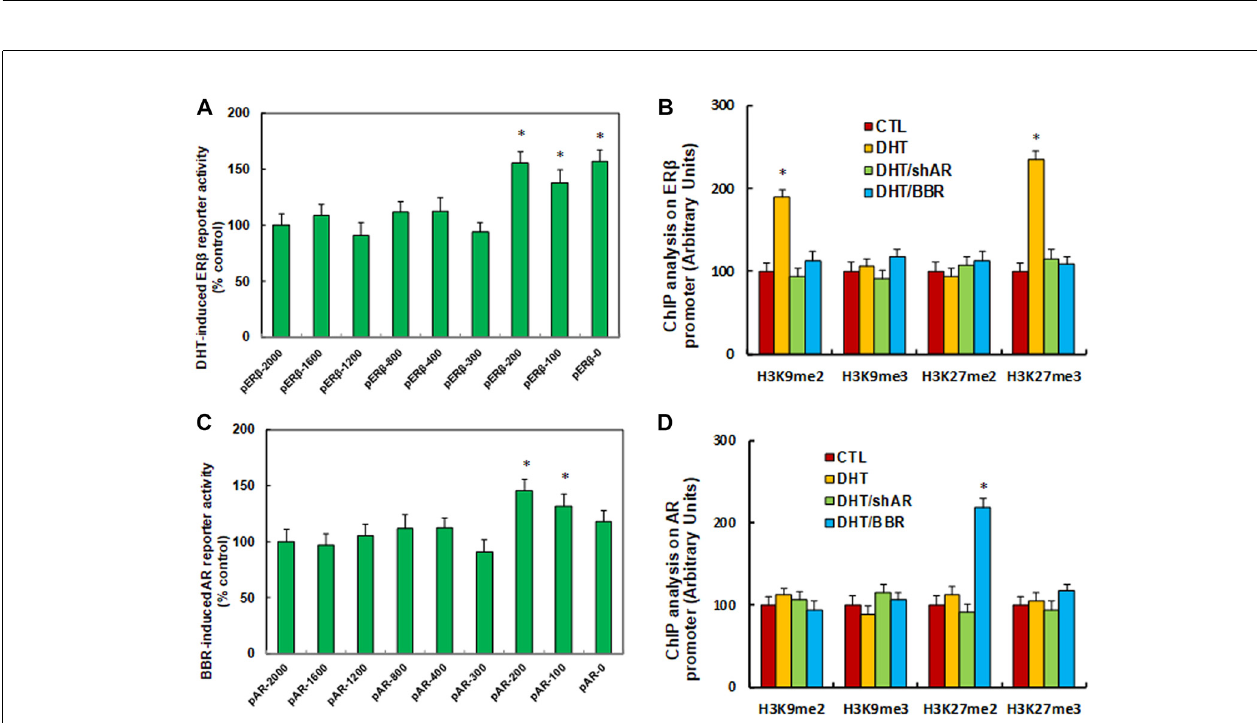
FIGURE 2 | DHT-mediated ER β suppression and BBR-mediated AR suppression by histone methylation on the promoters. (A) The conditional immortalized ACS-5003 neurons were transiently transfected by either ER β full length (pER β -2000) or deletion reporter plasmids. After 24 h, the cells were treated by either control (CTL) or 10 nM DHT for 24 h, and DHT-induced relative reporter activities (% control) were calculated, n = 4. ∗ P < 0.05, vs. pER β -2000 group. (B) The human ACS-5003 neurons were treated by CTL, 10 nM DHT (DHT), DHT with AR knockdown by lentivirus (DHT/shAR), or DHT with BBR (DHT/BBR) for 24 h, and cells were harvested for ChIP analysis, n = 4. ∗ P < 0.05, vs. CTL group. (C) The conditional immortalized ACS-5003 neurons were transiently transfected by either AR full length (pAR-2000) or deletion reporter plasmids. After 24 h, the cells were treated by either CTL or 10 µ M BBR for 24 h, and BBR-induced relative AR